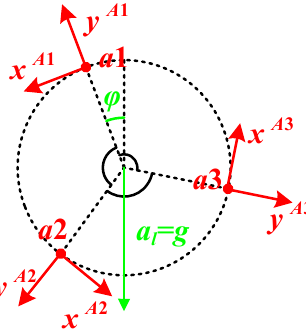
Figure 14. Rotational angle evaluation in low speed.